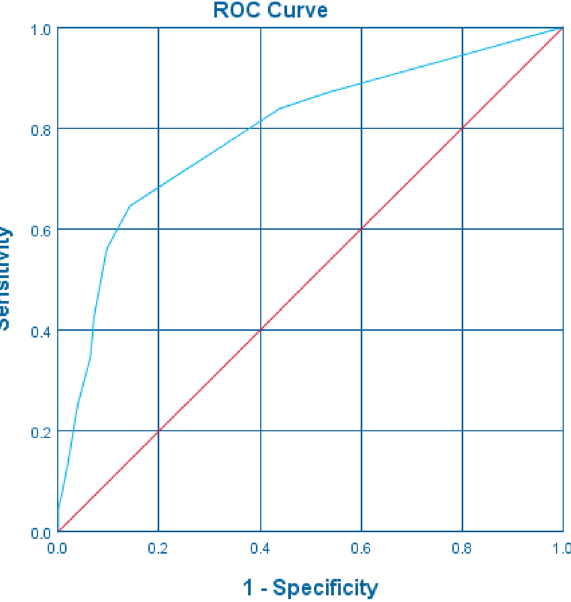
Figure 3. ROC curve for threshold selection of carbapenem-resistant Enterobacterales risk prediction score. Area under the curve = 0.793 [95% CI 0.742–0.844] ( P < 0.001).